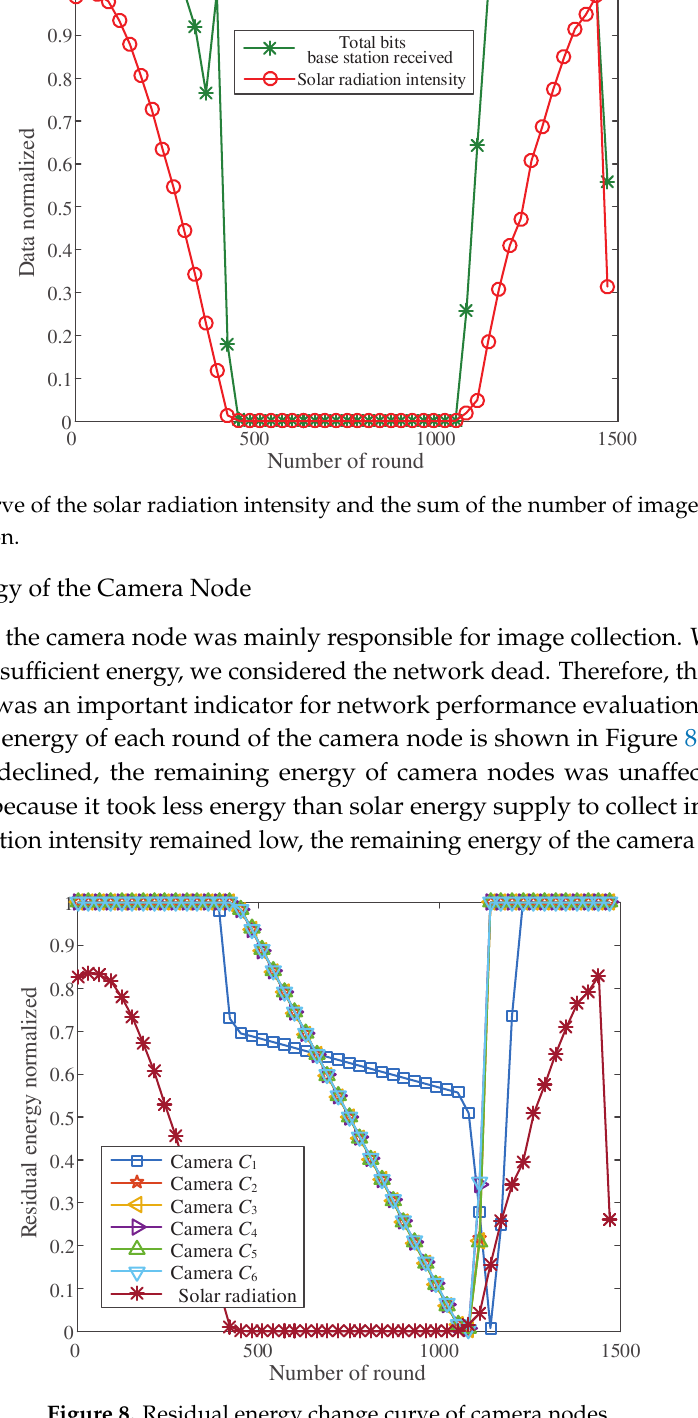
Figure 8. Residual energy change curve of camera